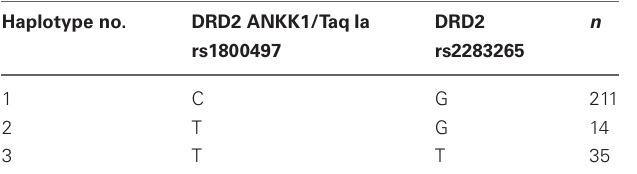
Table 3 | Empirical haplotype frequencies. Haplotype no.